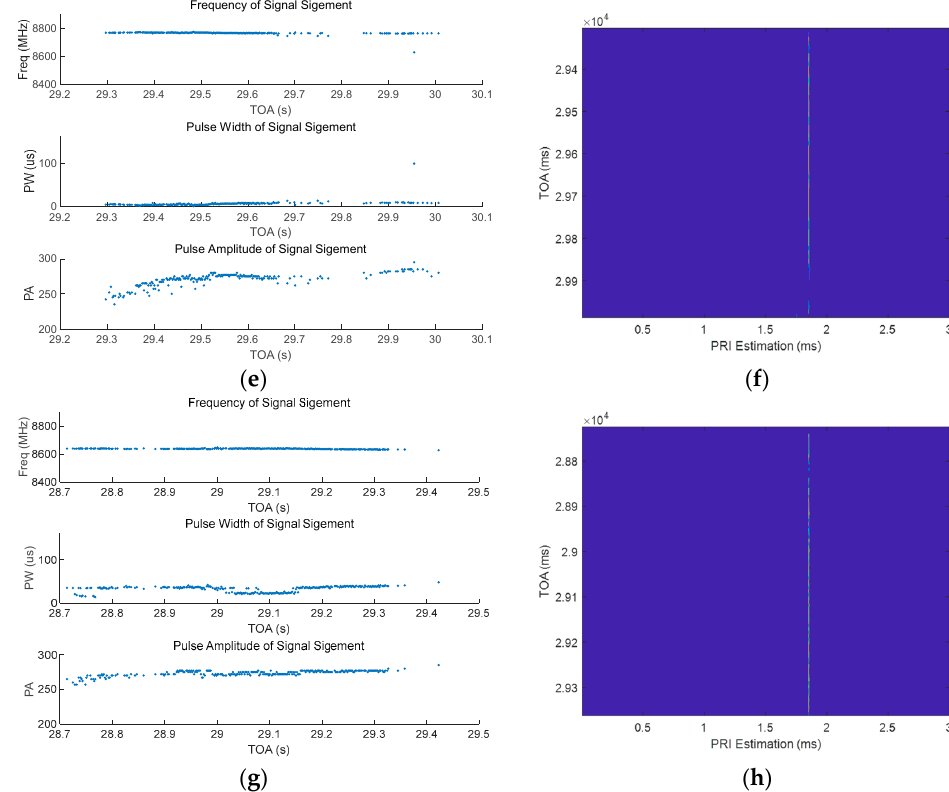
Figure 15. AP-CNN sorting results: ( a ) Class_739 carrier frequency, pulse width, and amplitude; ( b ) PRI of Class_739; ( c ) Class_348 carrier frequency, pulse width and amplitude; ( d ) PRI of Class_348; ( e ) Class_454 carrier frequency, pulse width and amplitude; ( f ) PRI of Class_454; ( g ) Class_169 carrier frequency, pulse width, and amplitude; ( h ) PRI of Class_169.